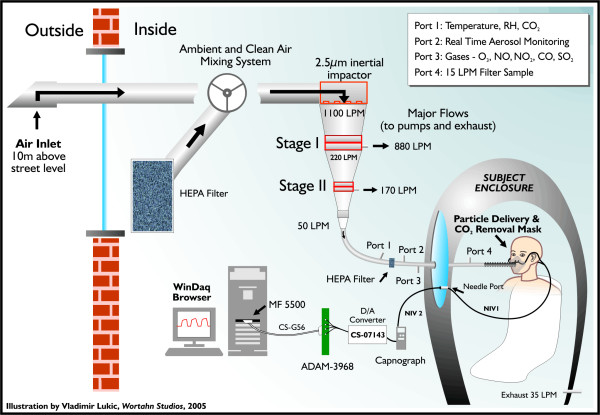
Capnography components added to existing HEF design. This illustration presents customized hardware & software components for the capnographic wave signal acquisition, interfaced with existing HEF used for the air pollution studies.